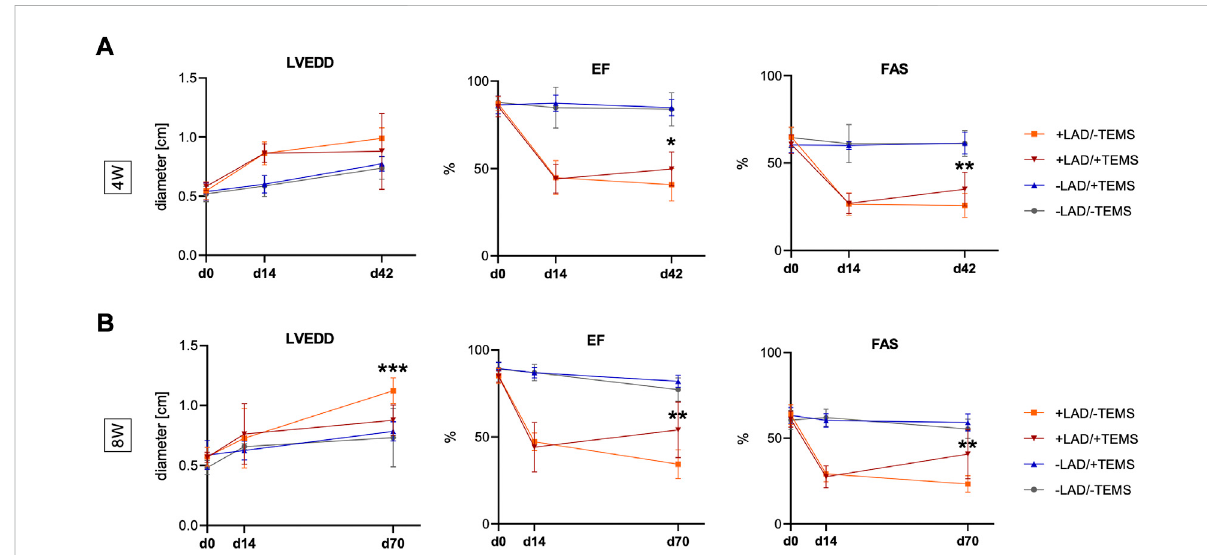
FIGURE 2 Echocardiographic parameters. Additional TEMS-implantation 14 days after LAD-ligature decreased LVEDD (left ventricular end-diastolic diameter) and improved left ventricular EF (ejection fraction) and FAS (fractional area shortening) after 4 and 8 weeks. (A) LVEDD, EF and FAS 14 days after LAD-ligature (+LAD) and 4 weeks after TEMS-implantation (+TEMS) or respective shame operations (-LAD; -TEMS), showing signi fi cantly improved EF and FAS in the +LAD/+TEMS as compared to the +LAD/-TEMS-group, and no signi fi cant differences between the -LAD/-TEMS and -LAD/+TEMS group. (B) LVEDD, EF and FAS 14 days after LAD-ligature and 8 weeks after TEMS-implantation or respective shame operations, showing signi fi cantly reduced LVEDD as well as improved EF and FAS in the +LAD/+TEMS-group as compared to the +LAD/-TEMS group, and no signi fi cant differences between the – LAD/-TEMS and – LAD/+TEMS group. Experimental groups: LAD/-TEMS, grey; -LAD/+TEMS, blue; +LAD/- TEMS, orange; +LAD/+TEMS, red. Data presented as mean ± SD; *, p < 0.05; **, p < 0.01; ***, p <